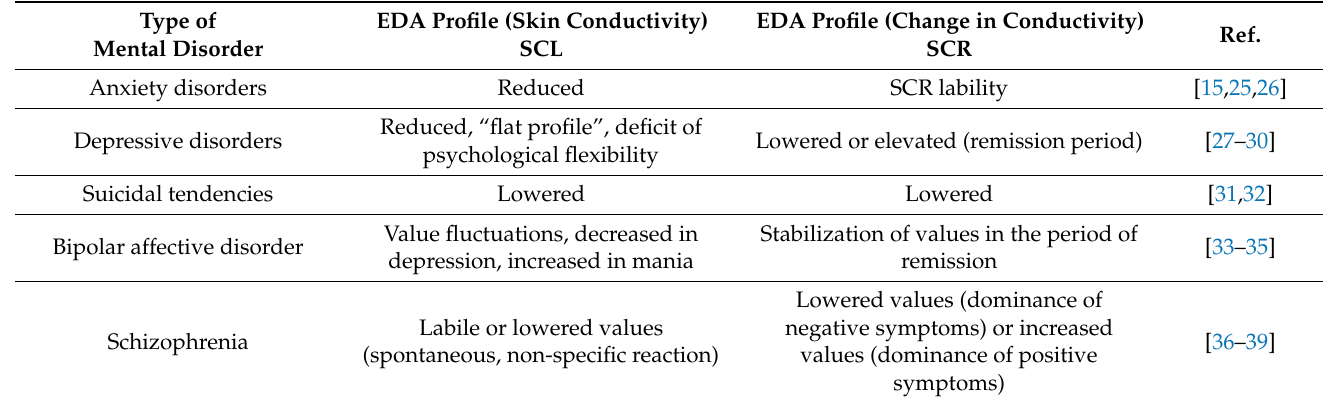
Table 1. Mental disorders and the EDA profile (SCL and